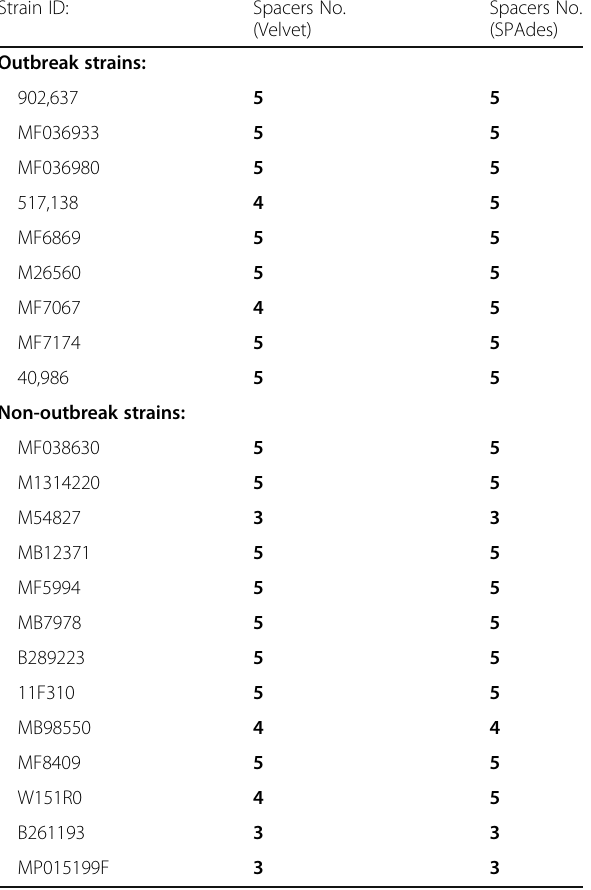
Table 3 Number of spacers within CRISPR1 locus in all Salmonella